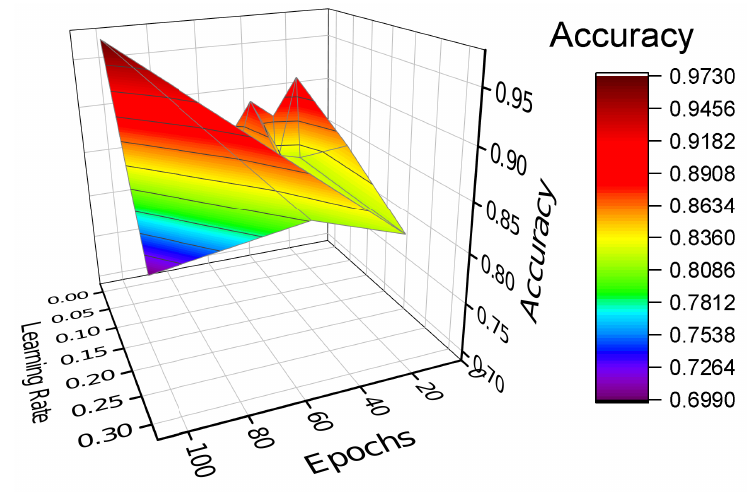
Figure 6. Hyperparameter